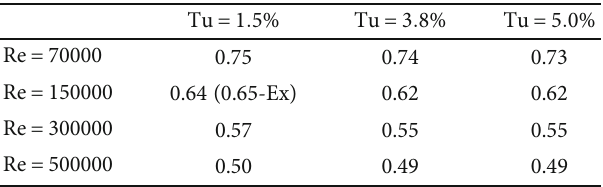
Table 4: Reattachment positions ( x / L ) with D12-7.